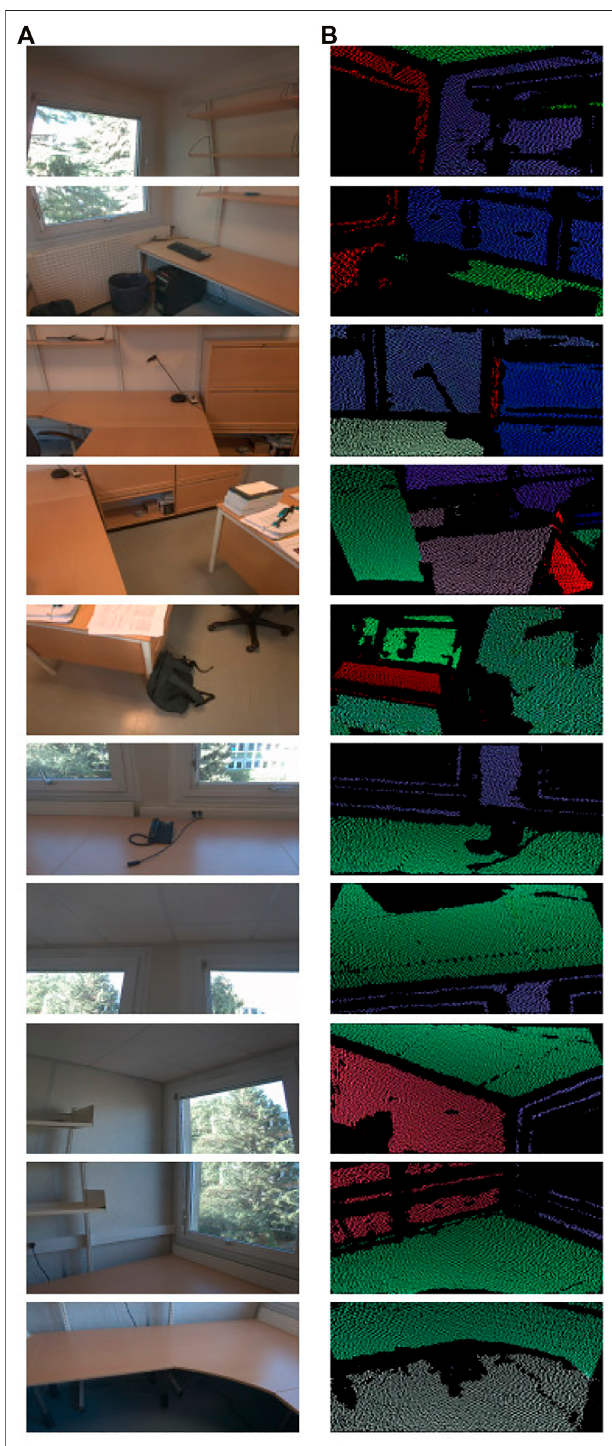
FIGURE 2 | Planar segmentation using our method. (A) : RGB images of the scene to be segmented. (B) : representation of the corresponding 3D points cloud with one color per plane orientation. Only the planes that are aligned with the building structure are detected.